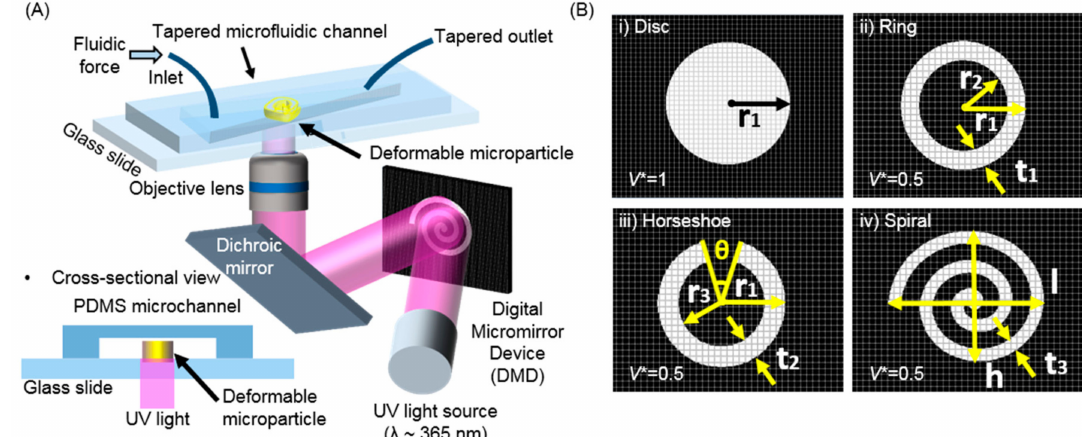
Figure 1. Microfluidic setup for the fabrication and deformation of microparticles with various shapes. ( A ) Schematic illustration of the optofluidic maskless lithography (OFML) setup. ( B ) Digital micromirror device (DMD) images for the selective UV exposure to form the corresponding microparticles. ( V * = effective volume index).